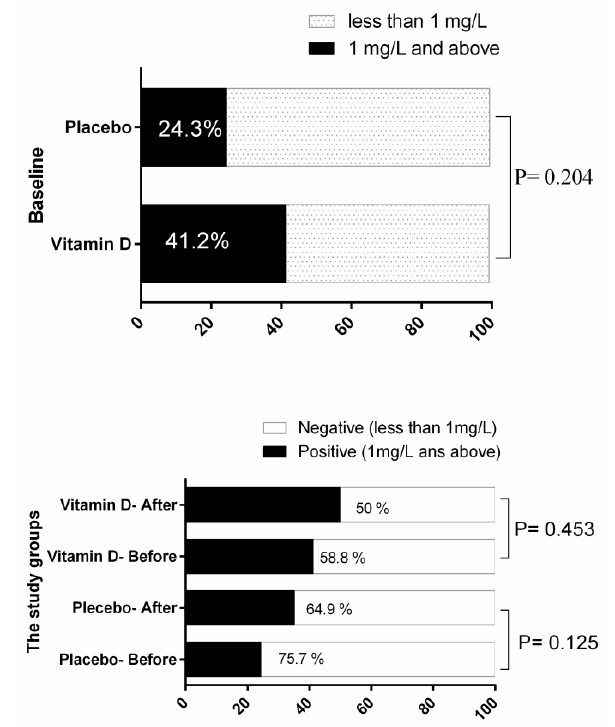
Figure 4. hs-CR p status in the study groups at the baseline and during the study period. Statistical analysis was done by Chi-Square and sign test. Data are presented as percentages. hs-CRP: high sensitive C-reactive protein.